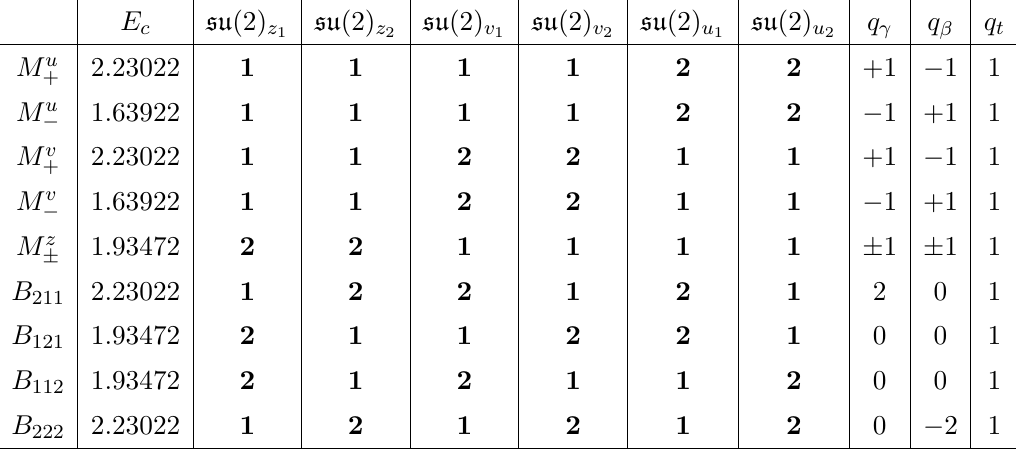
Table 9. Higgs branch operators of the T B SCFT that appear at the order τ 2 of the expansion.